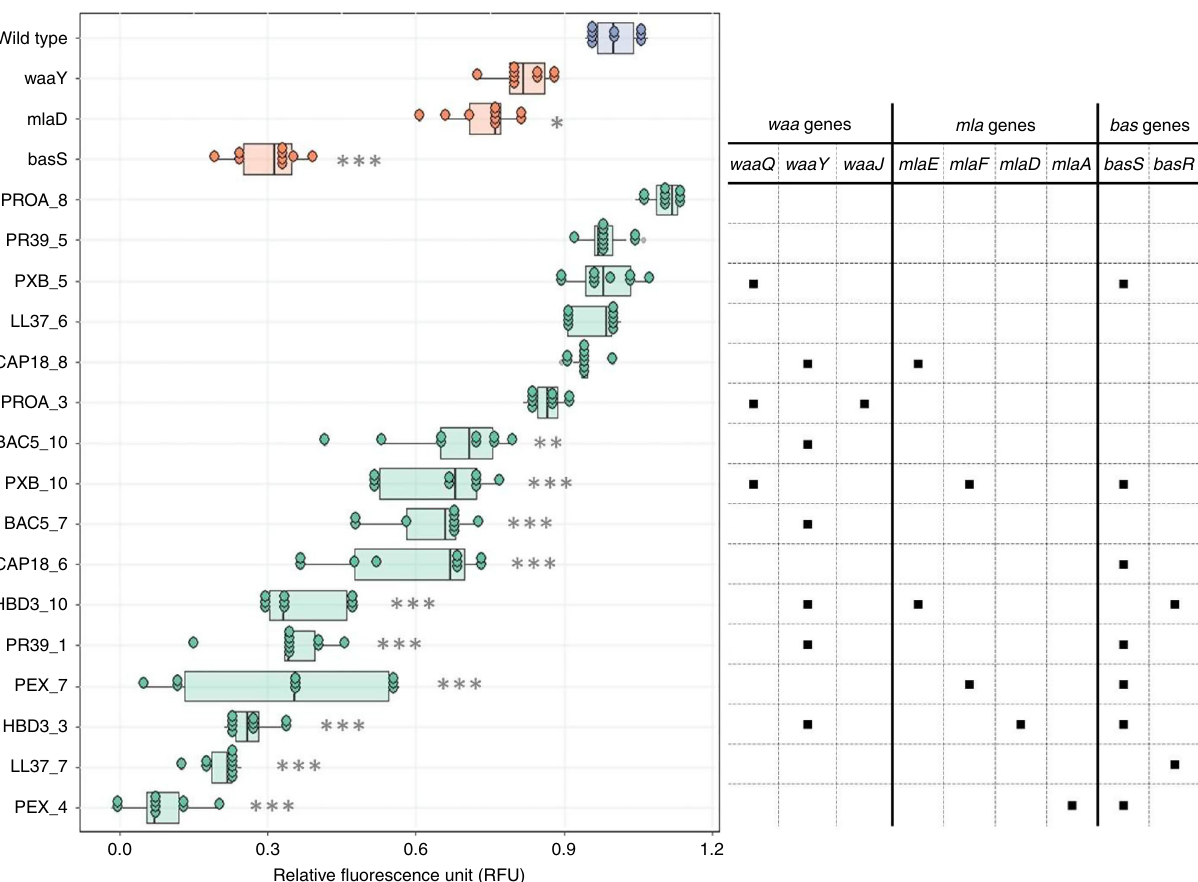
Fig. 5 Surface charge measurement. Relative surface charge was measured as the relative change in the binding of the positively charged FITC-PLL compared to the wild-type (see Methods). The table on the right side shows whether the adapted line carries a mutation in the waa or mla pathway genes or in the BasSR two-component system. AMP-resistant lines are named after the AMP it has been exposed to during the evolutionary experiment, and the serial number of the corresponding population. Each data point represents the relative fl uorescence unit of one of 9 biological replicate. Boxplots show the median, fi rst and third quartiles, with whiskers showing the 5th and 95th percentile. Signi fi cant differences compared to the wild type are marked with gray asterisks (* P < 0.05, ** P < 0.01, *** P < 0.001, two-sided Dunnett ’ s test, N = 9 each group). Source data are provided as a Source Data fi